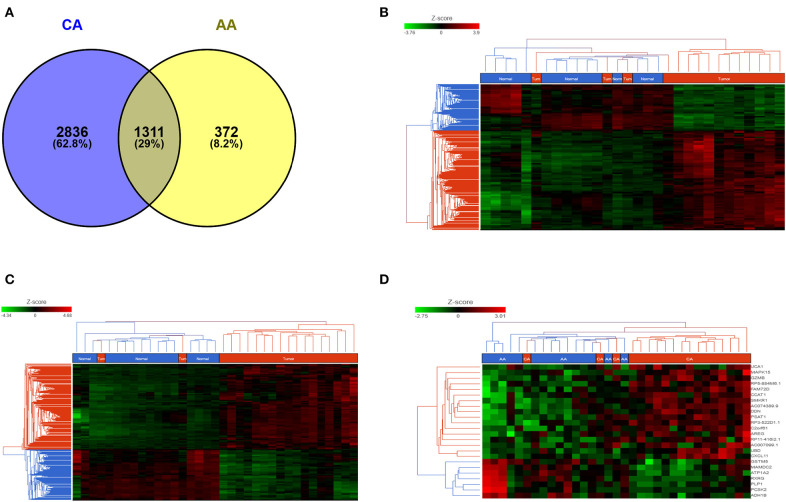
AA and CA tumors present different gene expression patterns. (A) Venn diagram depicting the number of common and unique genes in AA and CA colon tumors (compared to their respective non-tumor tissues). Analysis adjusted for multiple comparisons using FDR < 0.05 and fold change >2; Unsupervised hierarchical clustering of genes in AA (B) and CA (C) tumor tissues. Heat map for AA was generated using FDR < 0.05 and fold change >2; heat map for CA was generated at FDR < 0.05 and fold change >2; (D) Common genes (n = 1,311) between Tumor vs. non-tumor tissues (FDR < 0.05, fold change >3) in AA and CA were used to identify genes that may differentiate both tumor tissues from both ethnicities.